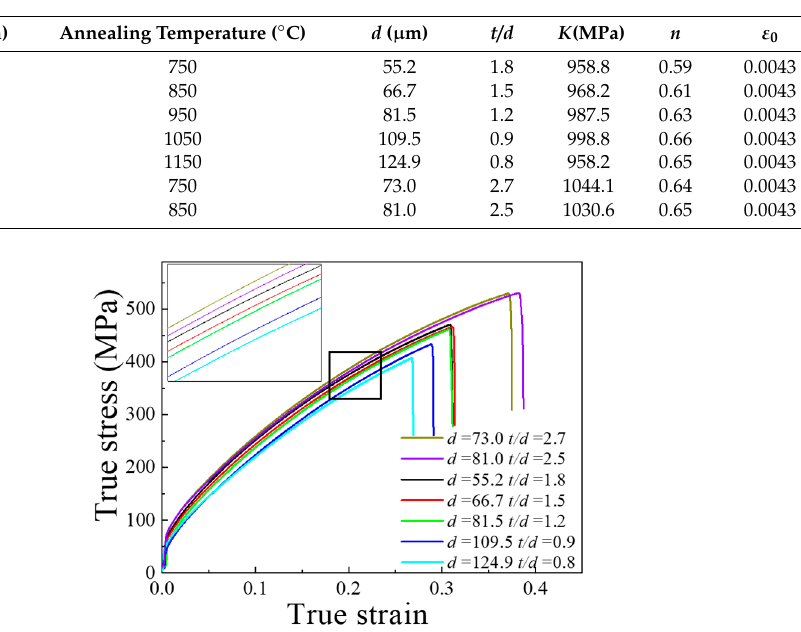
Table 1. Material parameters for the Swift model.